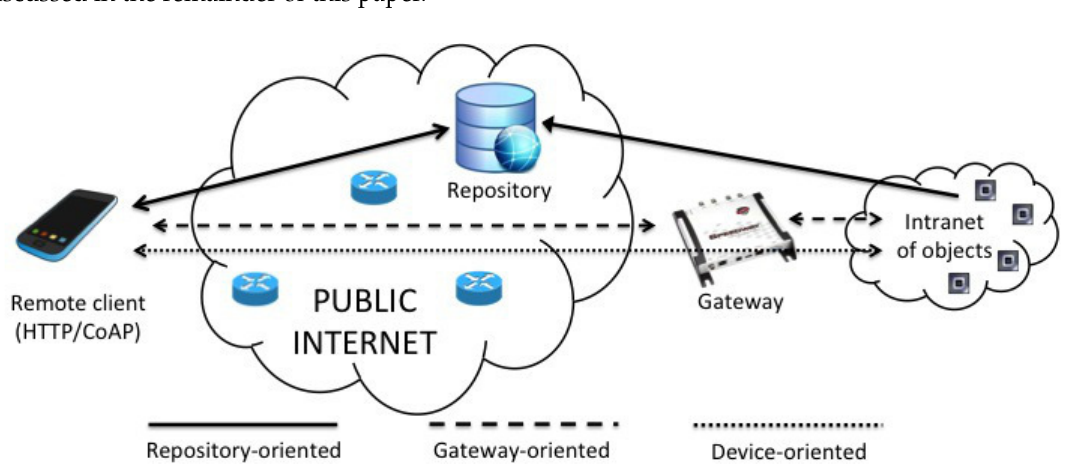
Figure 1. Representation of the three discussed approaches for RFID inclusion in the